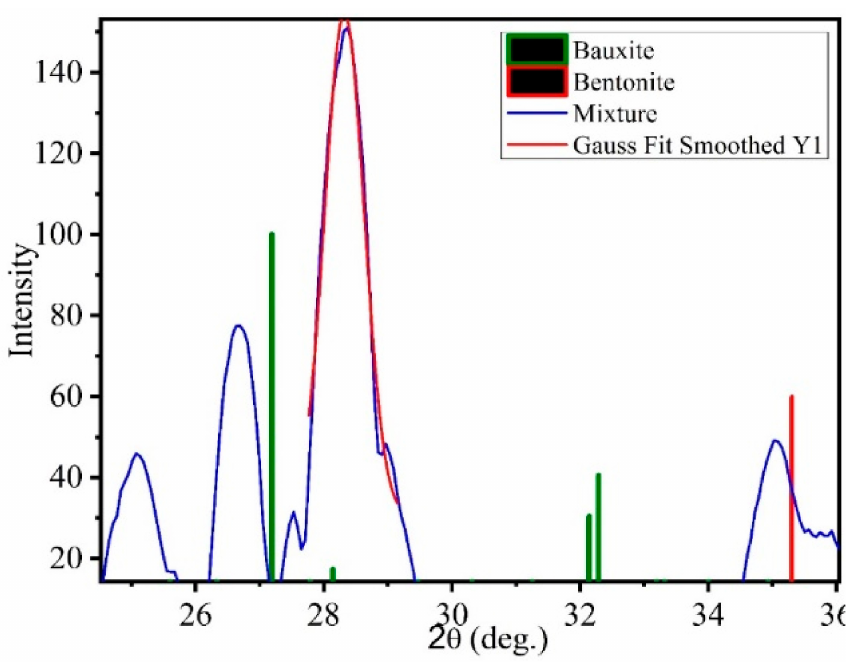
Figure 22. Gaussian fitting of bauxite and bentonite.